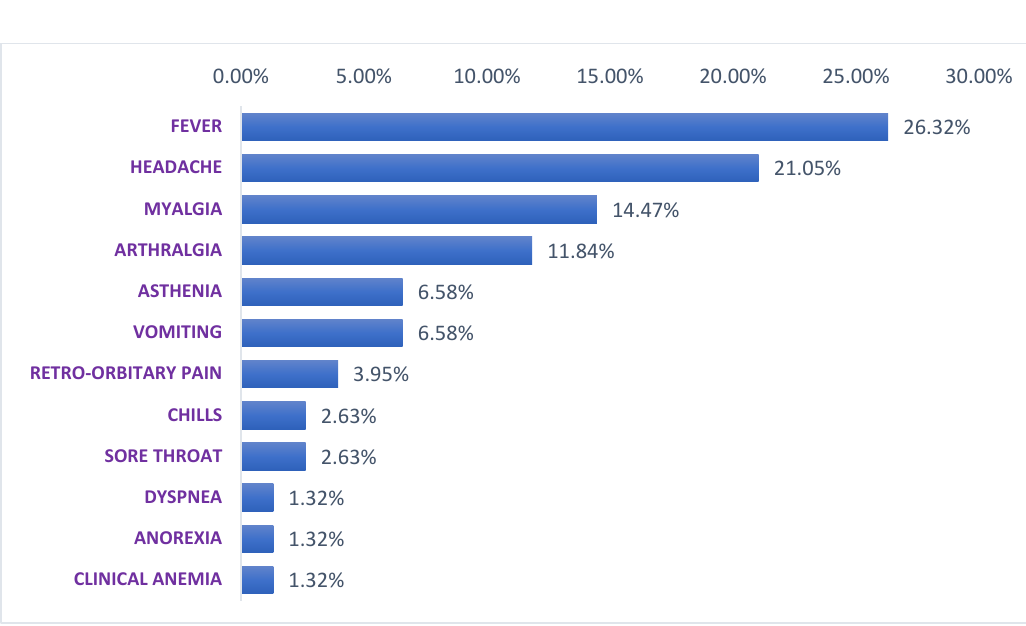
Figure 4. Clinical signs presented by people infected with WNV in Senegal from 2016 to 2021.